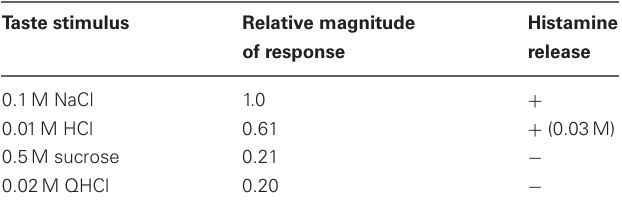
Table 1 | The relationship between the chorda tympani response and hypothalamic histamine release induced by taste